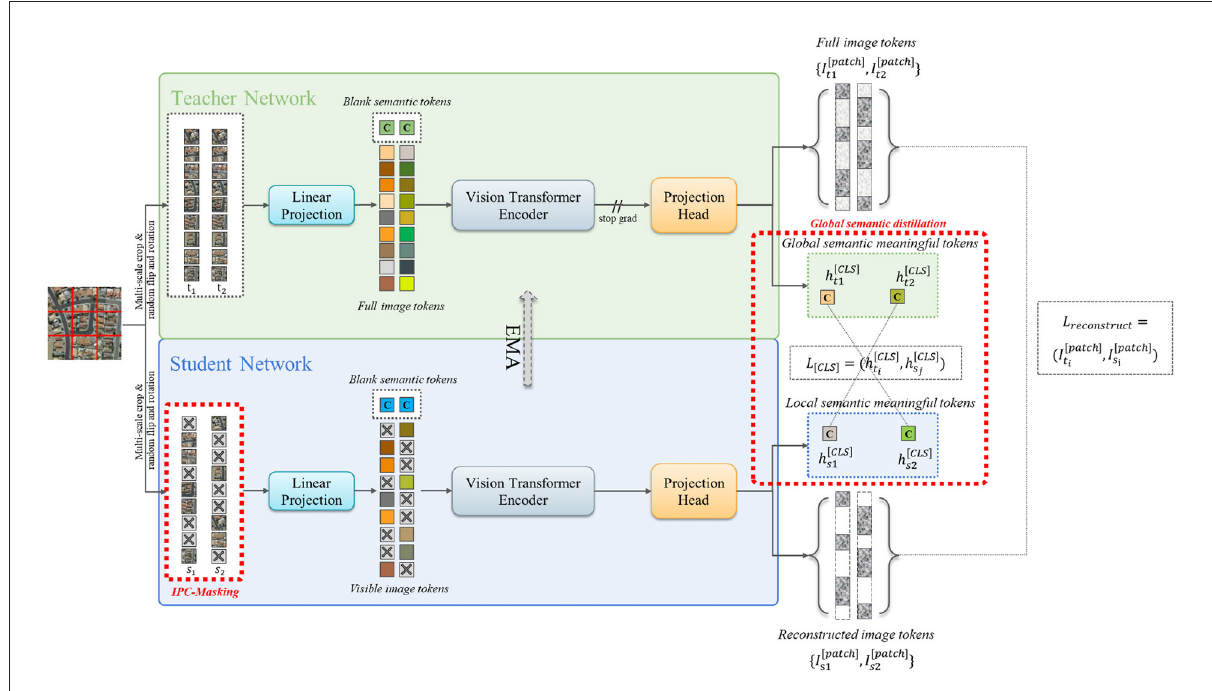
FIGURE2 The architecture of GSC-MIM.